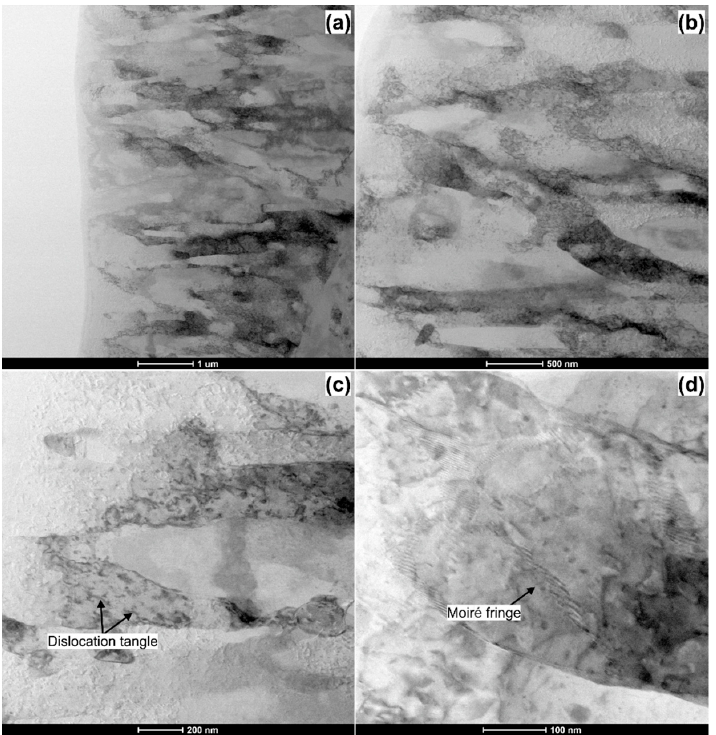
Figure 8. STEM bright-field images of the AlMg3 sample deformed with the action of ultrasonic vibrations. ( a ) low magnification image of the deformed area; ( b ) high magnification image of the deformed area; ( c ) magnified image of the deformed area showing a dislocation tangle; ( d ) magnified image of the deformed area showing a Moiré fringes.